Question: Condense the content of this figure into a single sentence.
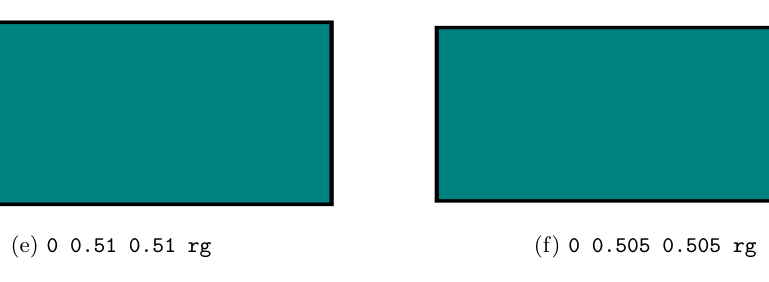
Answer: rg Operator - control, 20%, 10%, 5%, 2%, 1% (5%)